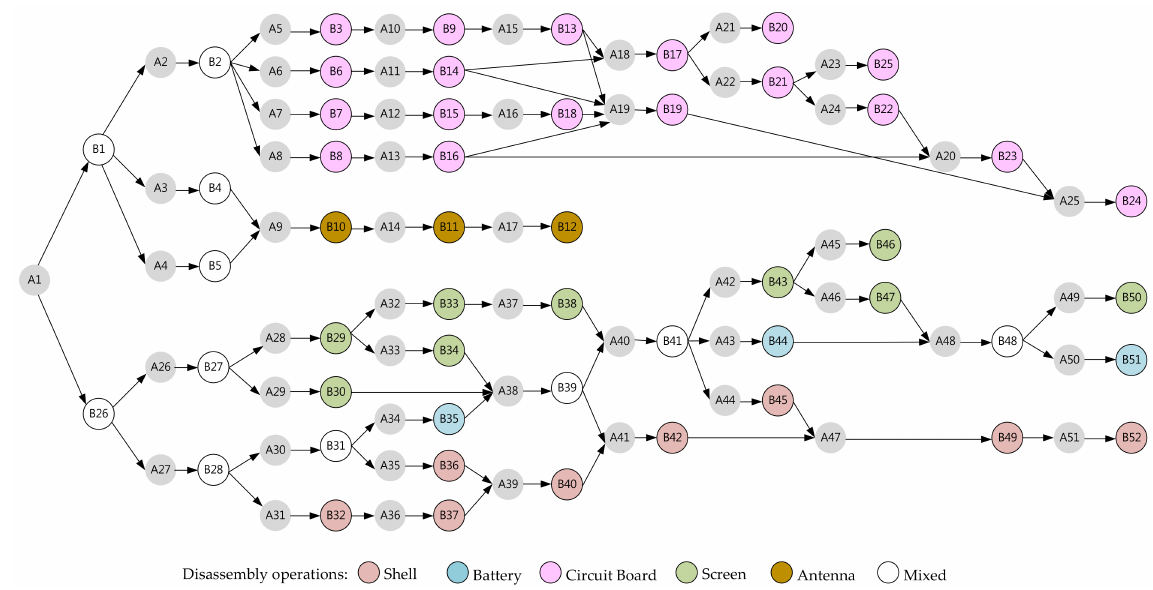
Figure 4. Disassembly chart of the studied mobile